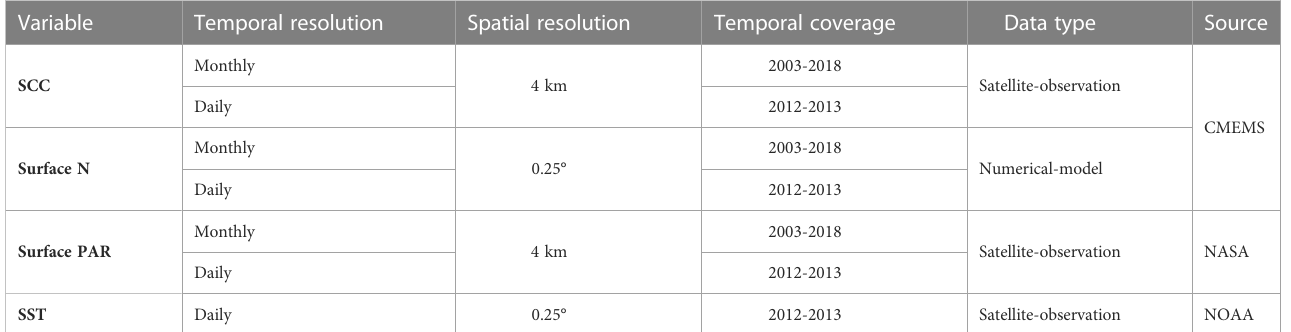
TABLE 1 Description of data used in the study.